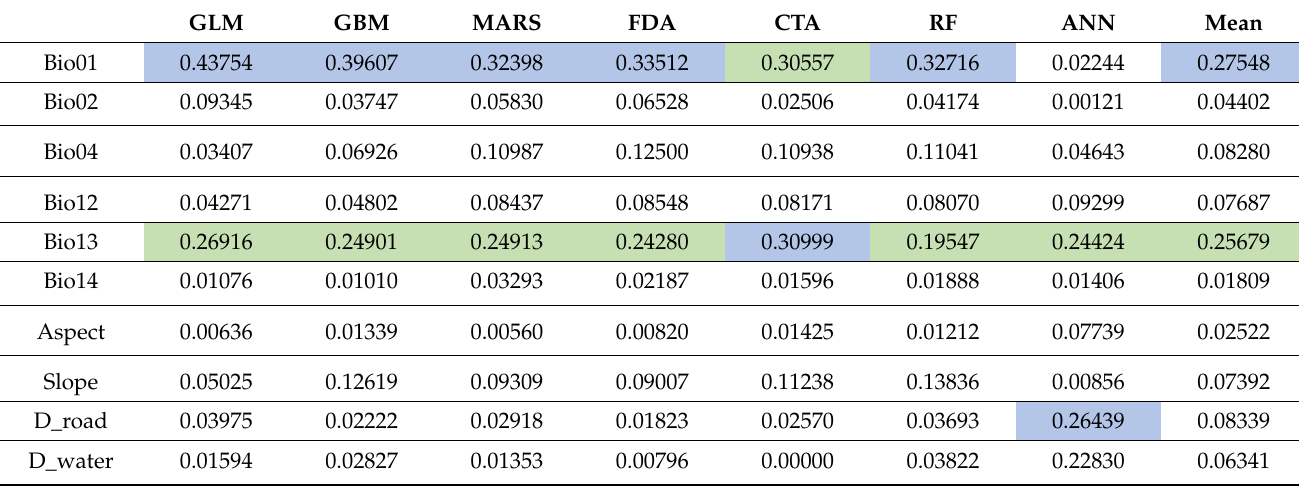
Table 4. Variable importance table derived from BIOMOD2 modeling results. The sum of the variable importance values was normalized to 1 for each model. Values showing the highest importance in the single model are highlighted using a blue color, and values showing the second highest importance are highlighted using a green